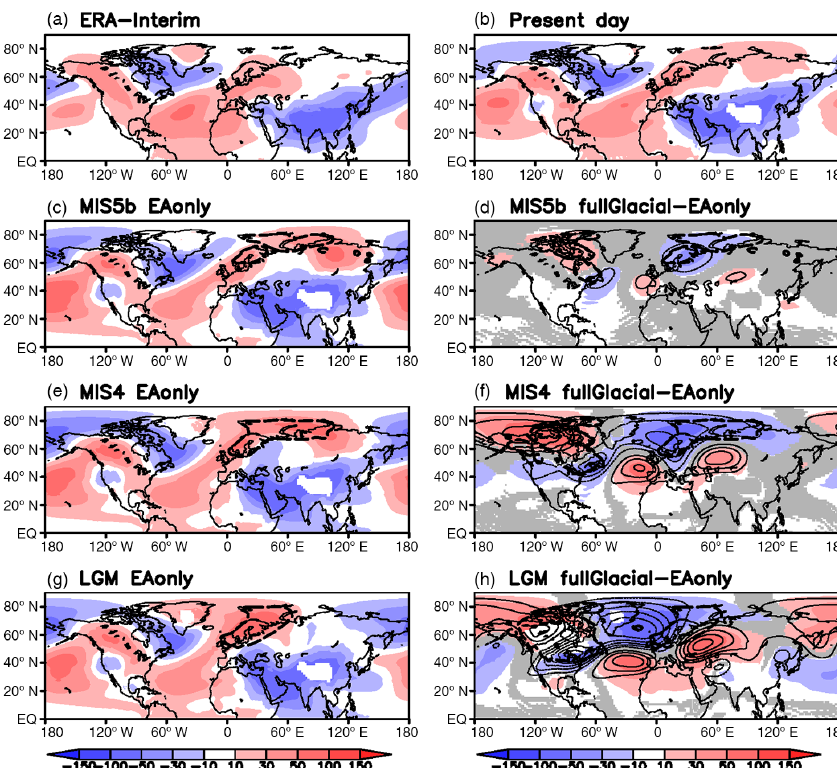
Figure 6. Same as Fig. 5 but for the JJA geopotential height anomalies (in m; zonal mean subtracted) at 700hPa (shading) and 300hPa (black contours in (d) , (f) , (h) ; contour interval is 30m, and negative values are dashed). Positive anomalies refer to an anticyclonic circulation anomaly and negative anomalies to a cyclonic circulation anomaly. Only significant changes at 95% (based on Student’s t test) are shown in (d, f, h) (nonsignificant changes are displayed in